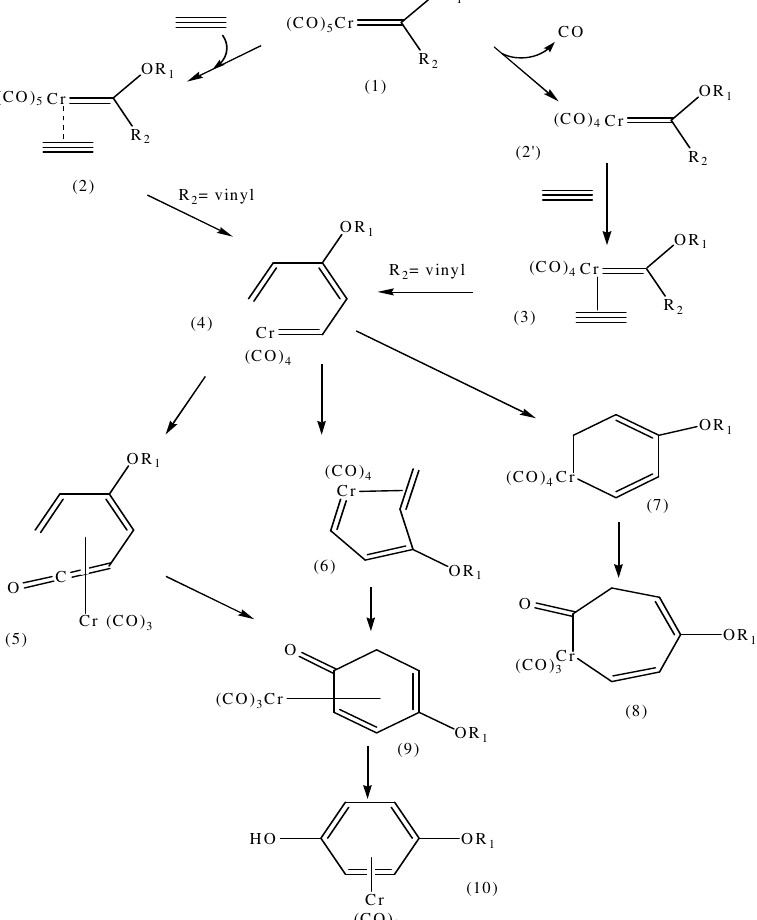
Figure 1. Proposed pathways for the benzannulation reaction (Dötz